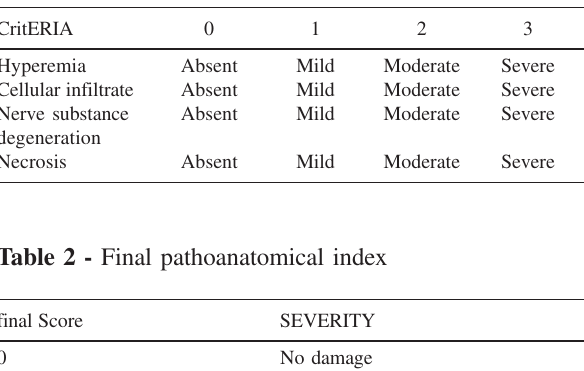
Table 1 - Specific pathoanatomical index